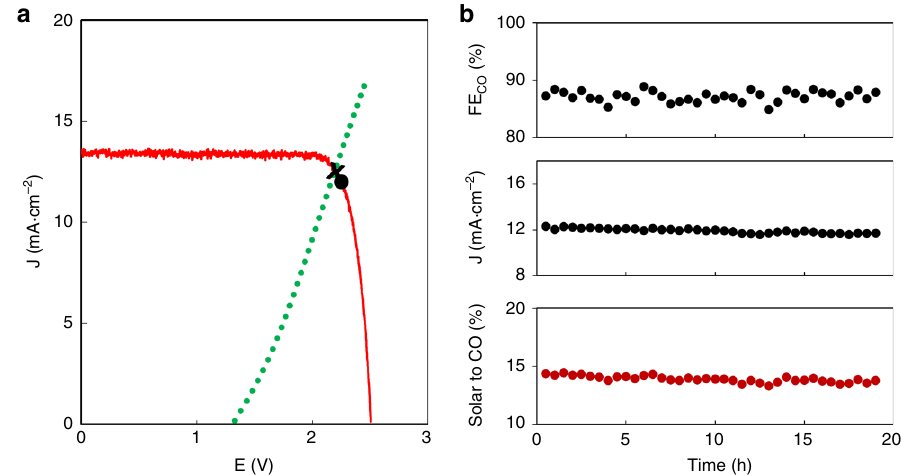
Fig. 4 Sunlight-driven CO 2 reduction using Sr 2 GaCoO 5 anode for oxygen evolution and anodized silver cathode for CO 2 reduction. a Current density – voltage characteristics of the photovoltaic (red) and electrolysis cell (green). The photovoltaic performance is shown under illumination of standard AM 1.5G solar light and 100 mW·cm − 2 intensity (1 sun) and its maximum power point is marked by a black dot. The calculated intersection is shown as the black cross. b Faradaic ef fi ciency, solar current density and STF CO ef fi ciency for the total operation of 19 h. The fl uctuation of STF CO was mainly attributed to the change of Faradaic ef fi ciency by as much as 4% due to the sensitive CO selectivity on the potential applied on a-Ag cathode Table 1 Comparison of the performance of sunlight-driven CO 2 reduction devices Device con fi guration Ef fi ciency Duration